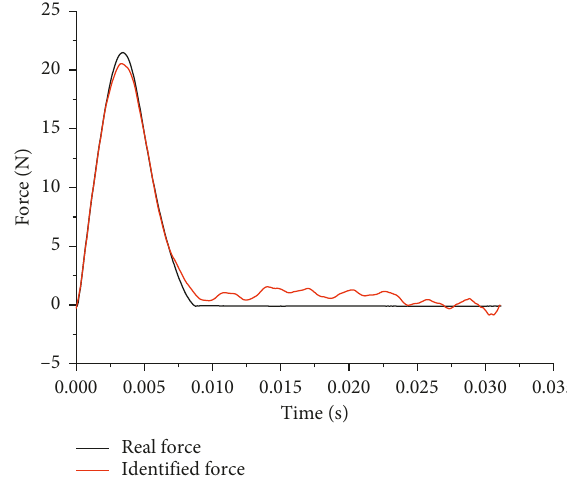
Figure 21: The reconstruction of the impact C.